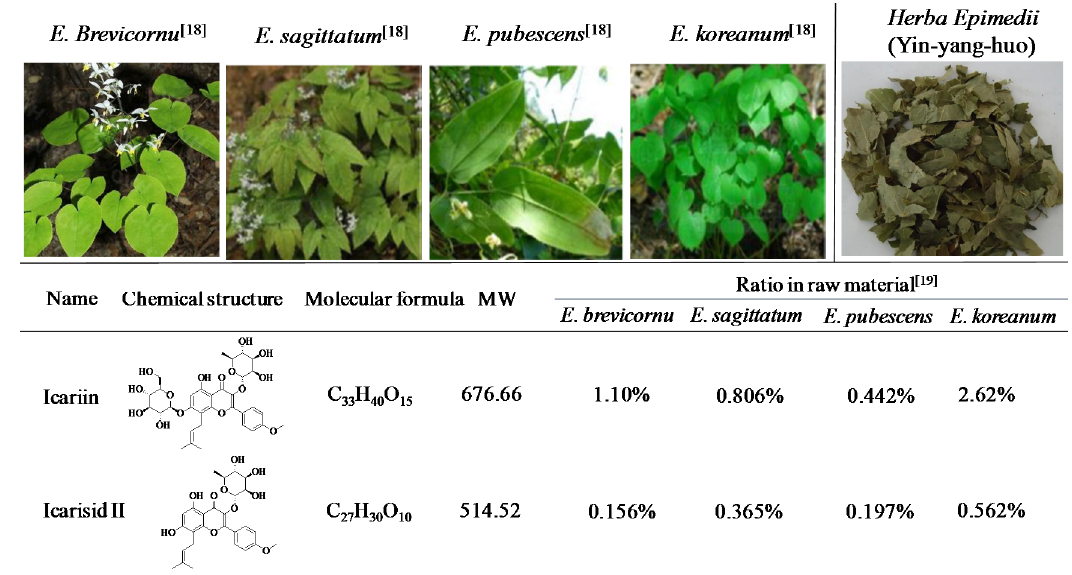
Figure 1. Natural sources and chemical structures of icariin and icariside II [18,19]. Herba Epimedii